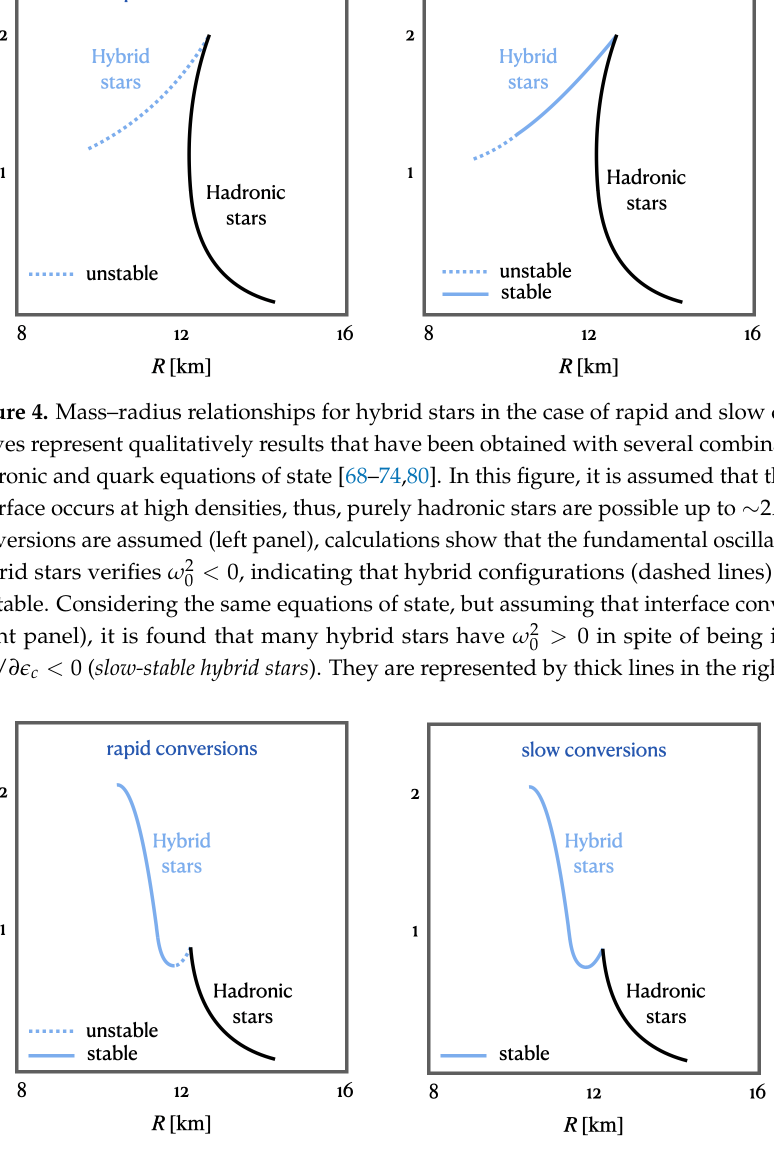
Figure 5. Same as in the previous figure but for a scenario where the hadron–quark interface occurs at low densities. Purely hadronic stars do not have large masses. For rapid conversions (left panel), there > 0, indicating is a hybrid star branch for which the fundamental oscillation frequency verifies ω 2 0 stability. There is also a small segment of the curve (with dashed lines) which is unstable because < 0 (this segment also verifies ∂ M / ∂(cid:101) c < 0). Considering the same equations of state, but ω 2 0 assuming that interface conversions are slow (right panel), it is found that the short segment that is > 0) in spite of having ∂ M / ∂(cid:101) c < unstable in the left panel becomes dynamically stable ( ω 2 0